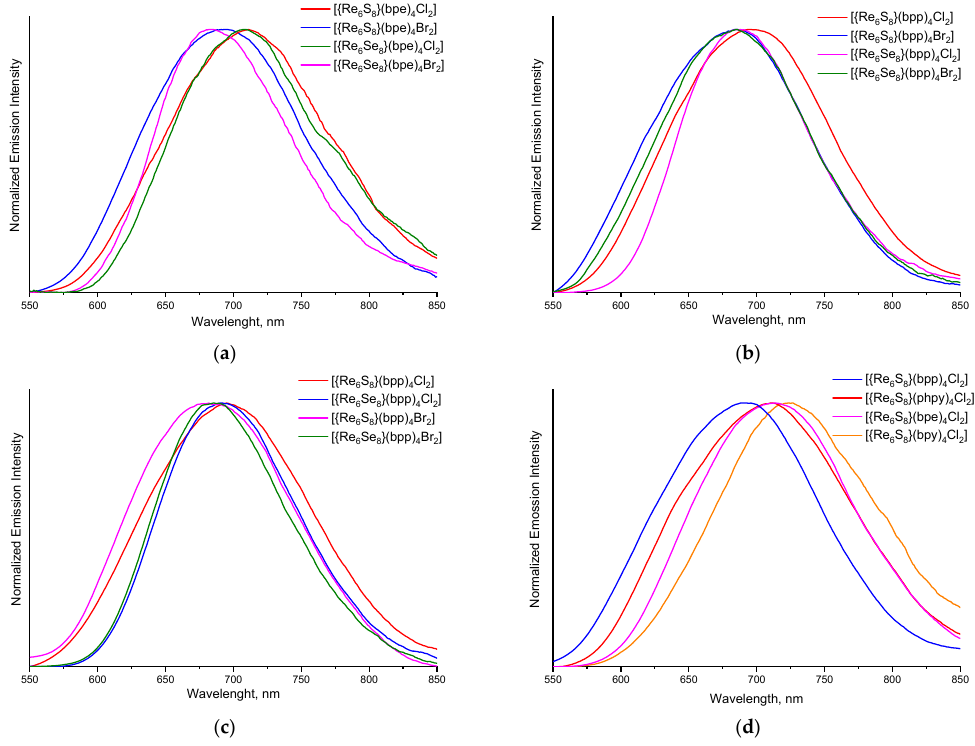
Figure 6. Normalized emission spectra of compounds 1 – 4 ( a ) and 5 – 8 ( b ) in the solid state, 5–8 in deaerated DMSO solution ( c ), as well as normalized solid-state emission spectra of a series of Table 1. Spectroscopic and photophysical parameters of trans -[Re 6 Q 8 L 4 X 2 ] complexes (L = bpp, bpe, phpy, bpy). For all compounds except trans -[Re 6 Q 8 (bpp) 4 X 2 ] measurements were carried out in solid state only due to low solubility. For compounds trans -[Re 6 Q 8 (bpp) 4 X 2 ] measurements were also carried out in dearated DMSO solution.